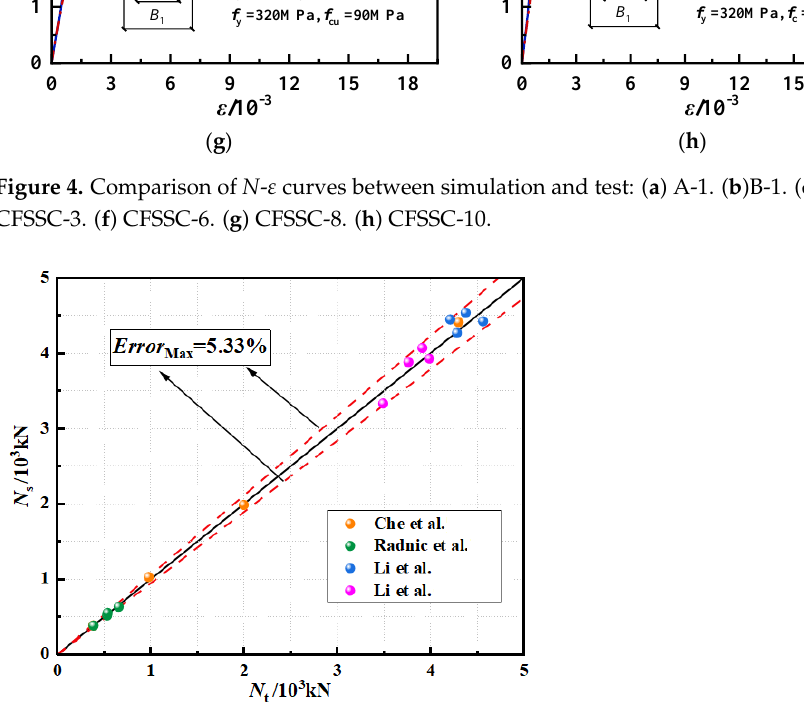
Figure 5. Comparison of N s and N t for sixteen specimens [41 – 44].